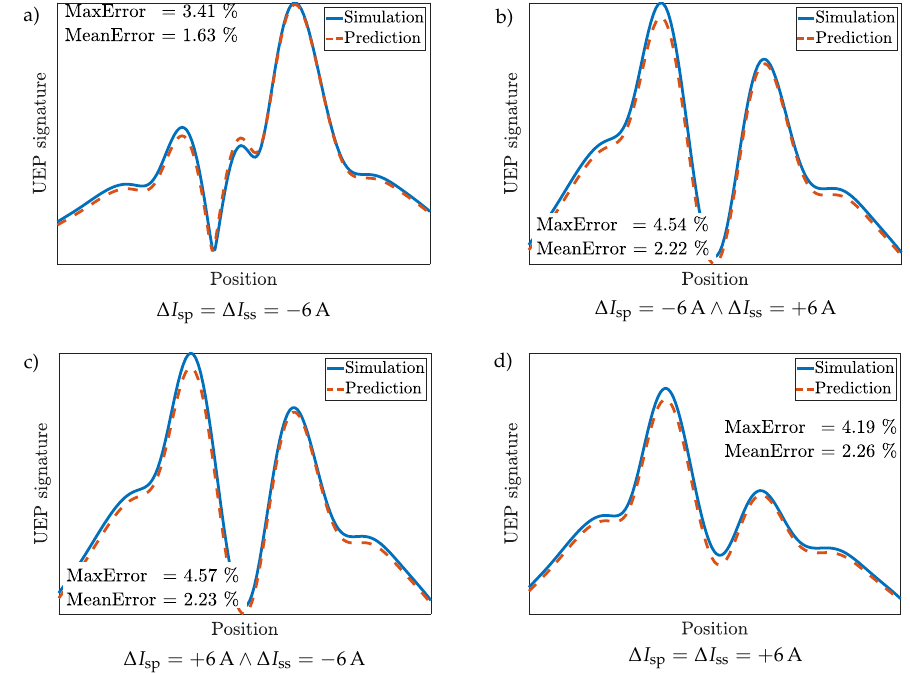
Figure 8. Scenario 3 (bare steel hull with coated propellers): Prediction example of the magnitudes of the UEP signature for changing the impressed currents (subfigure ( a – d )) of the ICCP electrodes at the stern using the prediction formulae of the Equations (8)–(10) and the polarization curve of bare steel for the hull and sea chests including coated propellers with a defined coating damage of 10% for each propeller. Implementing a coating to the propellers lowers the influence of the nonlinear corrosion process to the total UEP signature and significantly improves the prediction accuracy to a maximum deviation of approximately